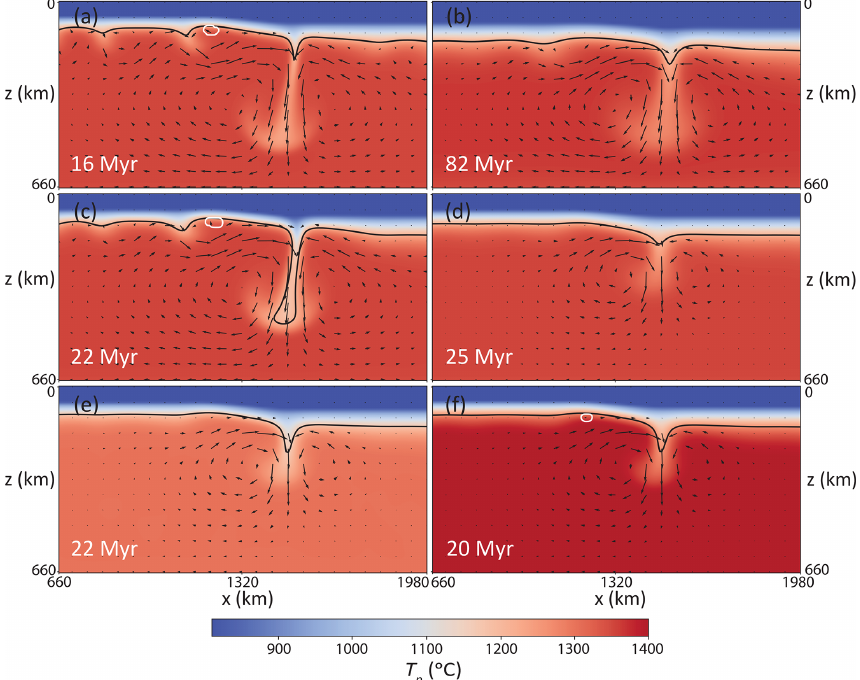
Figure 4. Effects of rheological parameters and reference temperature on edge-driven convection, shown by snapshots of potential tem- perature of various cases. (a) η 0 = 3 . 83 × 10 18 . (b) η 0 = 1 . 96 × 10 19 . (c) E a = 120kJmol − 1 . (d) E a = 300kJmol − 1 . (e) T ref = 1300 ◦ C. (f) T ref = 1400 ◦ C. White contours outline areas with active melting. Black contour refers to the isotherm of T = 1215 ◦ C = 0.9 T ref . Note that snapshots are chosen such that they show a similar stage of model evolution as in Fig. 3b (i.e., mature EDC major downwelling), while model times differ due to the effects of rheological parameters on onset and vigor of EDC or SSC. Also note that the reference case (Fig. 3b, c) corresponds to an intermediate case for the trends shown in any of the rows: η 0 = 8 . 61 × 10 18 ; E a = 200kJmol − 1 ; T ref = 1350 ◦ C.